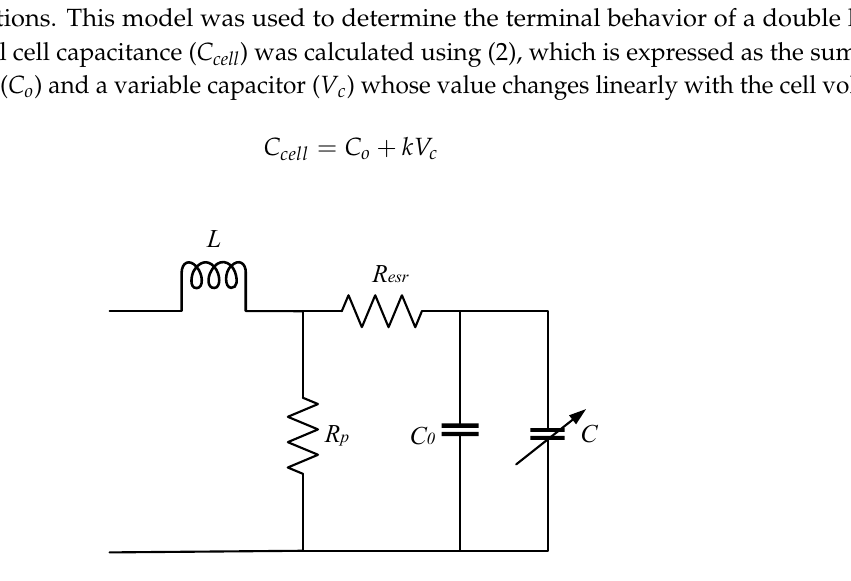
Figure 8. Variation of the classical equivalent circuit model of DLCs taking into account the linear change in cell capacitance of the capacitor, represented by a variable capacitor.